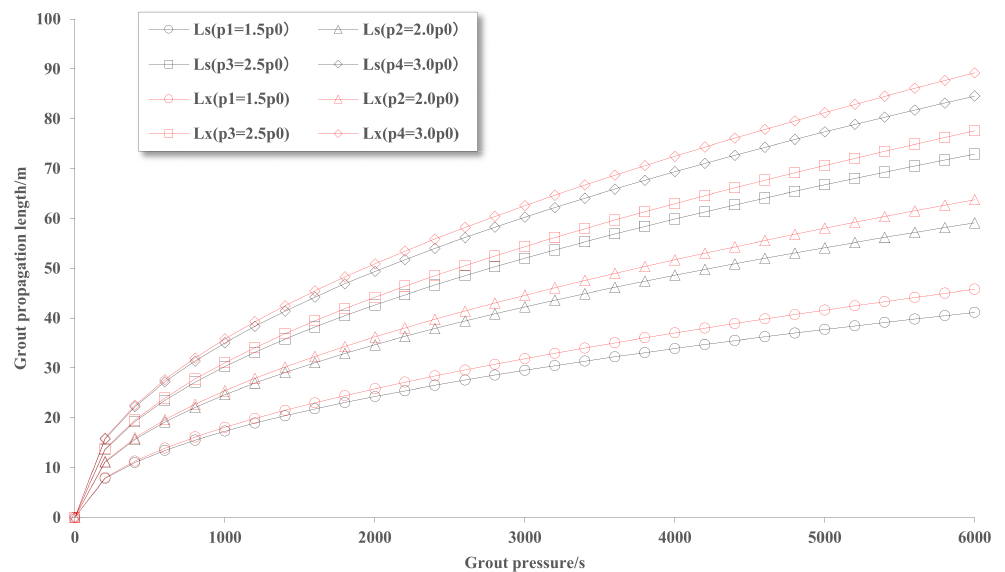
Figure 14. Calculation curve of slurry diffusion distance on top of Middle Ordovician limestone in No. 4 mining